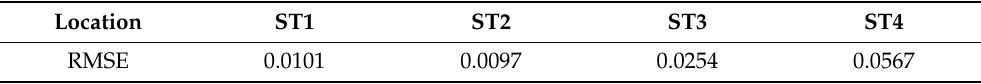
Table 1. The RMSE of velocity profiles at four different locations.